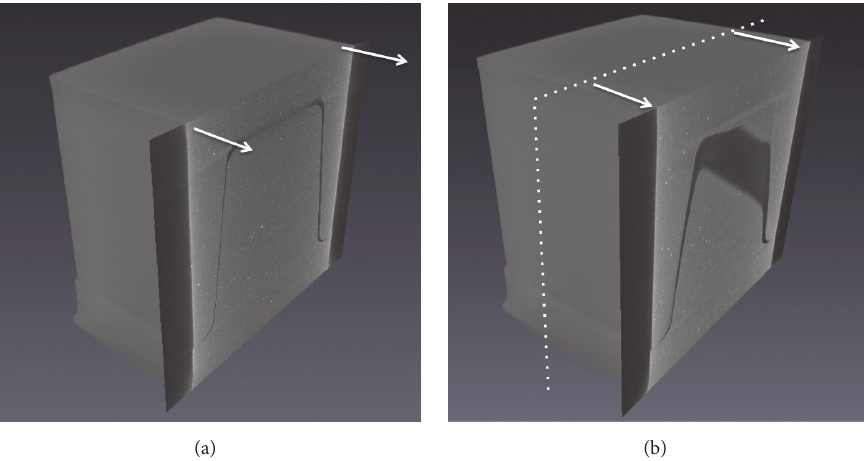
Figure 8: Direct 3D visualization of the pyramidal assembly. (a) A clipping plane has been added in the middle of the assembly. (b) A clipping plane has been added at a more marginal location.